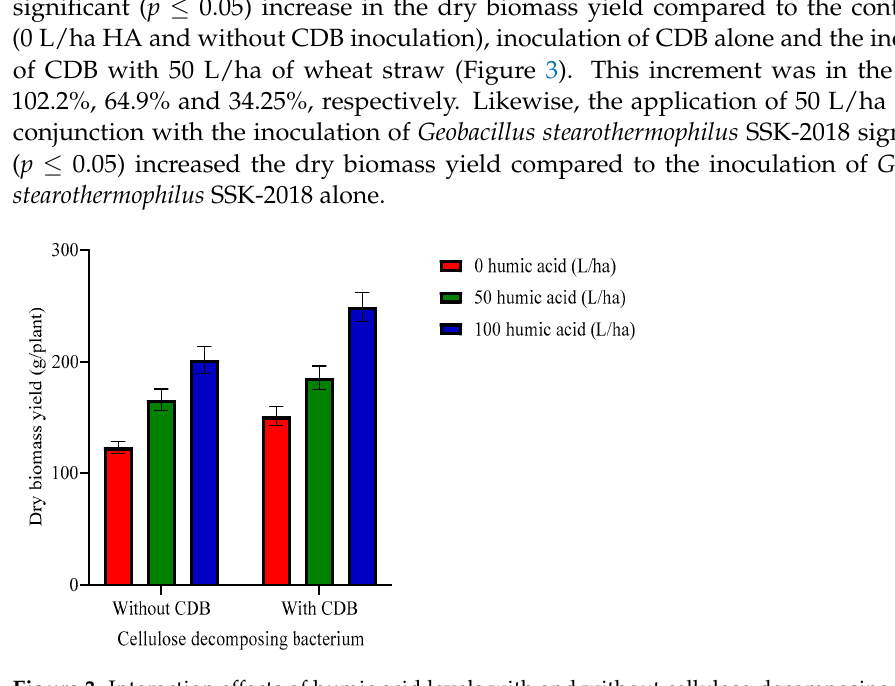
Figure 2. Three-way interaction effect of humic acid, cellulose-decomposing bacterium and wheat straw on the fresh biomass yield of squash in 2020 planting season. Bars indicate ± standard error, and error bars that are not overlapping each other indicate that the means are significantly ( p ≤ 0.05) different from each other.